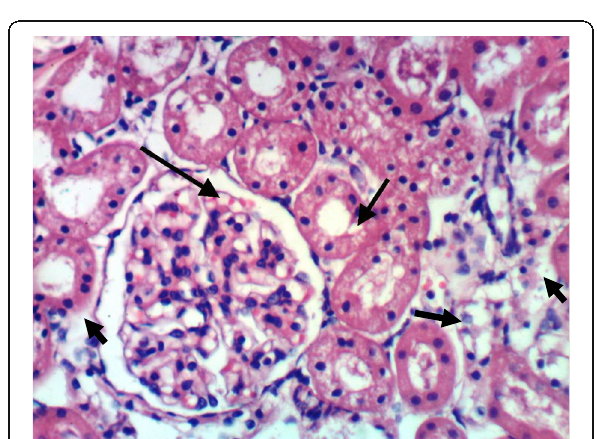
Fig. 10 Photomicrograph of rat ’ s kidney fed on balanced diet supplemented with taurine+pot.bromate, showing proteinaceous material and degeneration of the cells lining in distal convoluted tubules (H&E × 400)